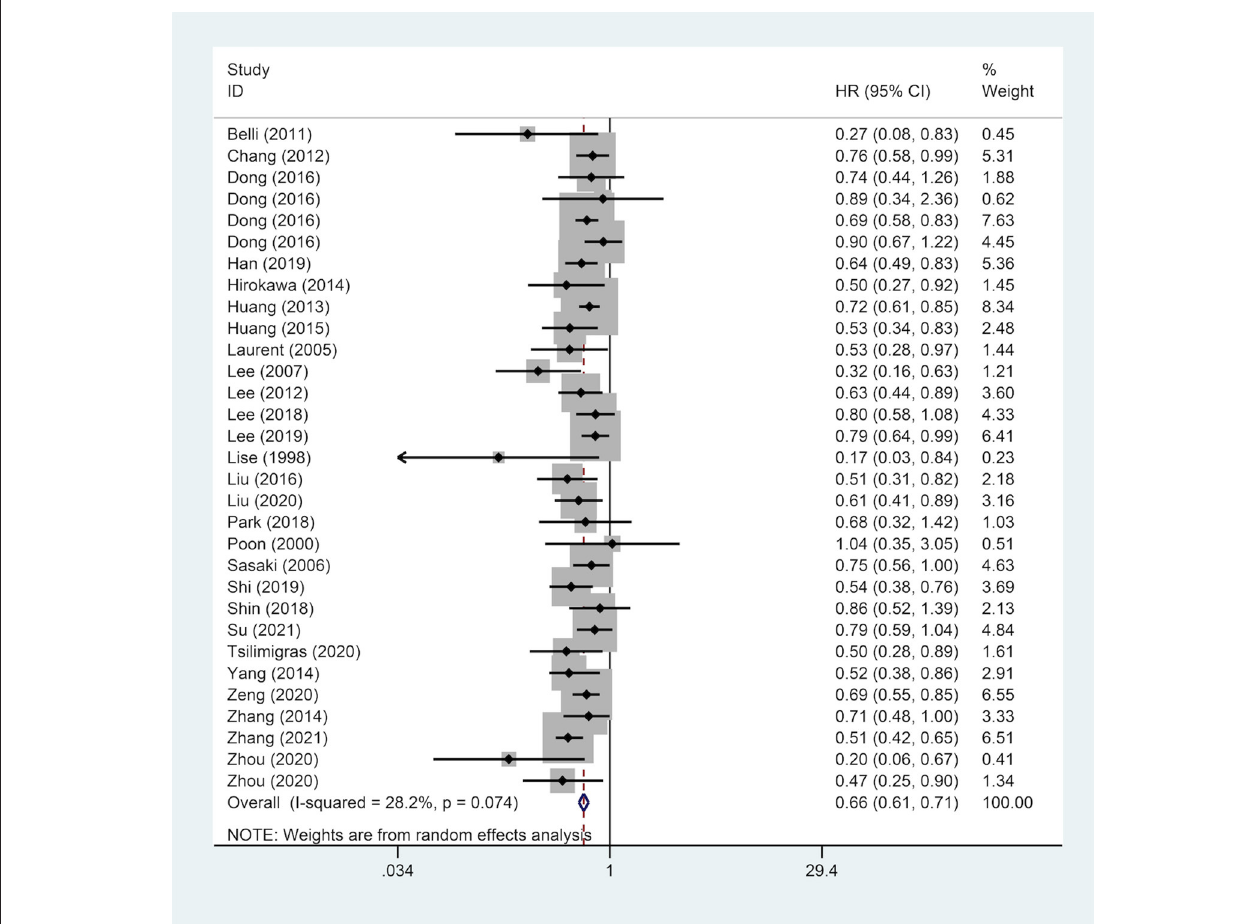
FIGURE 3 | Forest plot of DFS of HCC patients receiving wide surgical margin.